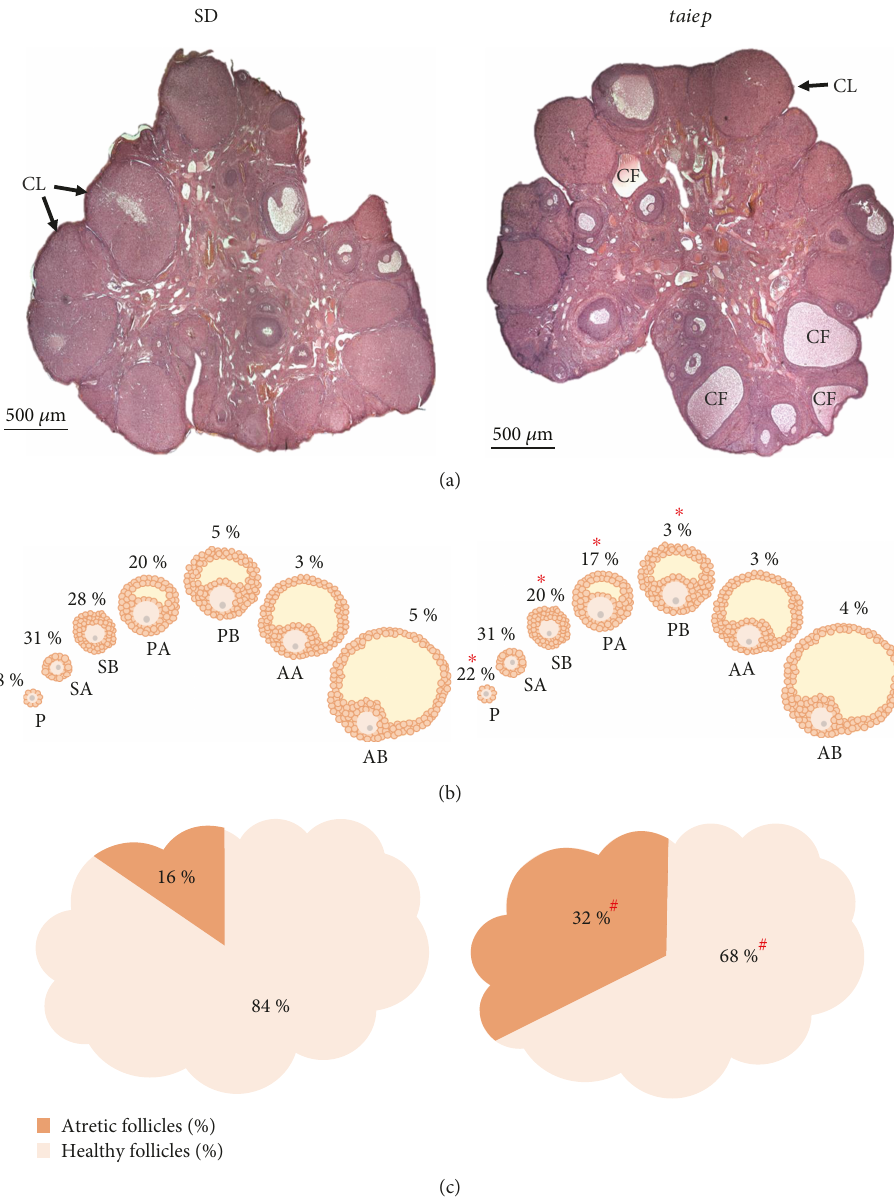
Figure 7: Follicle population in Sprague – Dawley and taiep rats in the adult stage. (a) Representative histological slice of the ovary. (b) Percentages of follicles in the di ff erent categories. (c) Percentages of atretic and healthy follicles in the ovary. SD: Sprague – Dawley; CF: cystic follicle; CL: corpora lutea; P: primary; SA: secondary A; SB: secondary B; PA: preantral A; PB: preantral B; AA: antral A; AB: antral B. ∗ p ≤ 0 01 z -test and # p ≤ 0 001 z